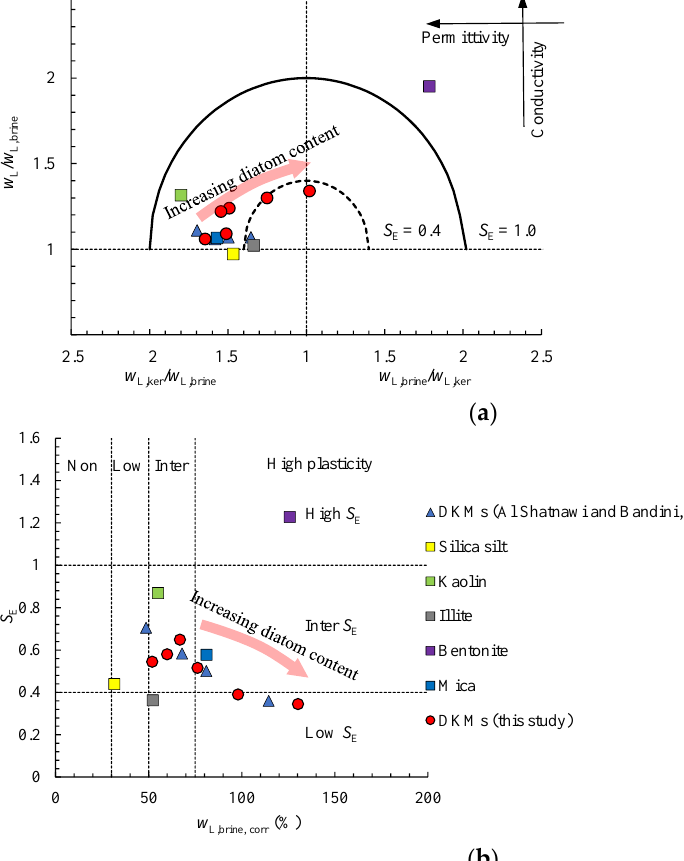
Figure 15. Classification of DS according to pore fluid sensitivity: ( a ) permittivity and conductivity of the samples; ( b ) electrical sensitivity of the samples. Data sources: DKMs [7].